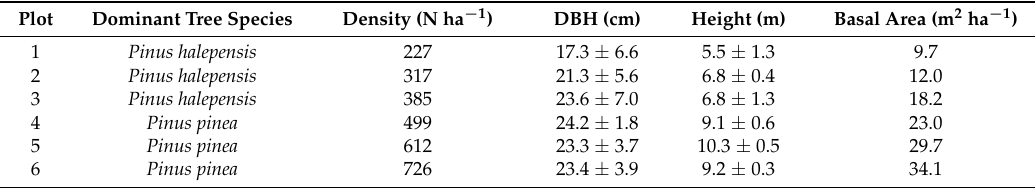
Table 1. Main dendrometric parameters of the pine canopy layer of the study plots. Means are followed by standard